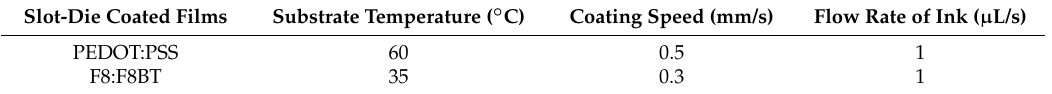
Table 1. Slot-die processing parameters used for coating PEDOT:PSS and F8:F8BT films.